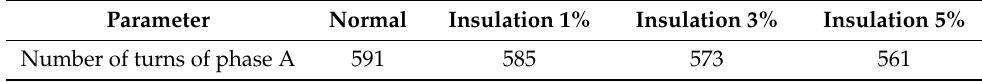
Table 4. Winding insulation parameter table.